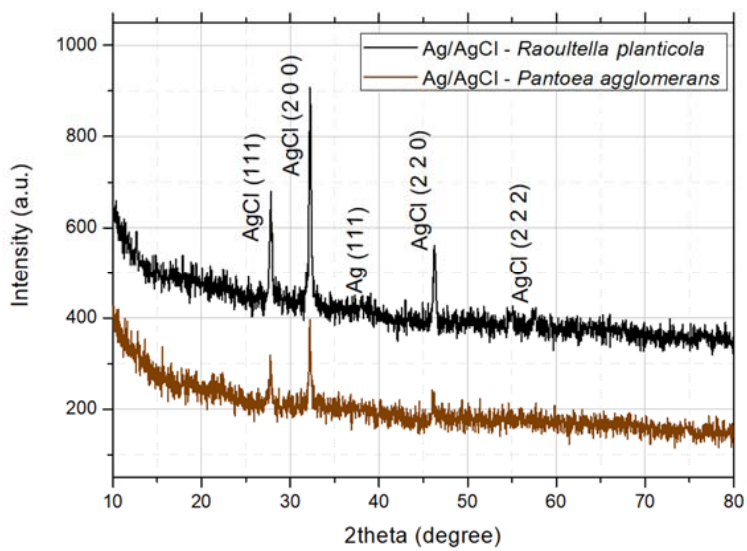
Figure 2. X-ray diffraction (XRD) patterns for Ag/AgCl nanoparticles biosynthesized by Gram- Figure 2. X ‐ ray diffraction (XRD) patterns for Ag/AgCl nanoparticles biosynthesized by Gram ‐ negative bacteria from the Enterobacteriaceae family. negative bacteria from the Enterobacteriaceae family .